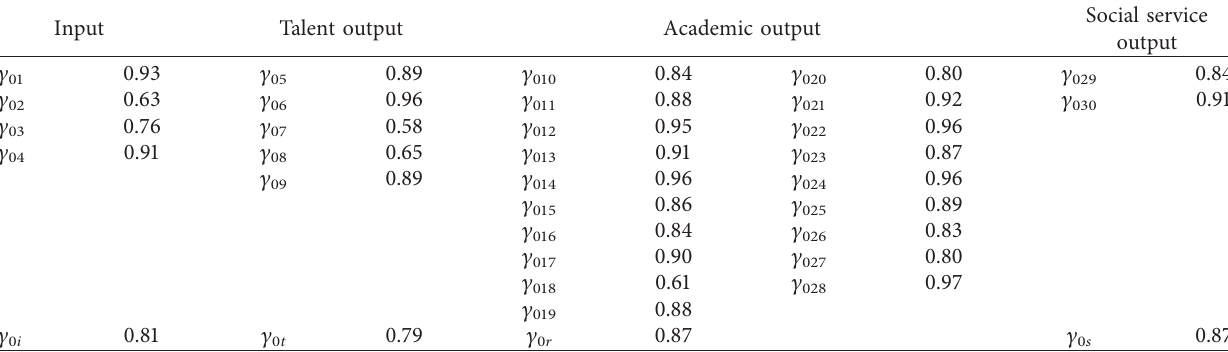
Table 4: Distribution of the gray relation degrees of the core competence indicators of Chinese research